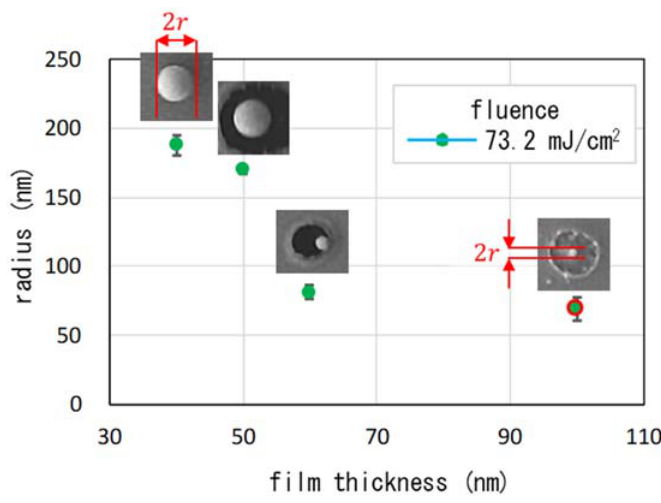
Figure 4. The radii of the nanoparticles as a function of film thickness. The fluence was 73.2 mJ/cm 2 . The error bars reflect the s.d.